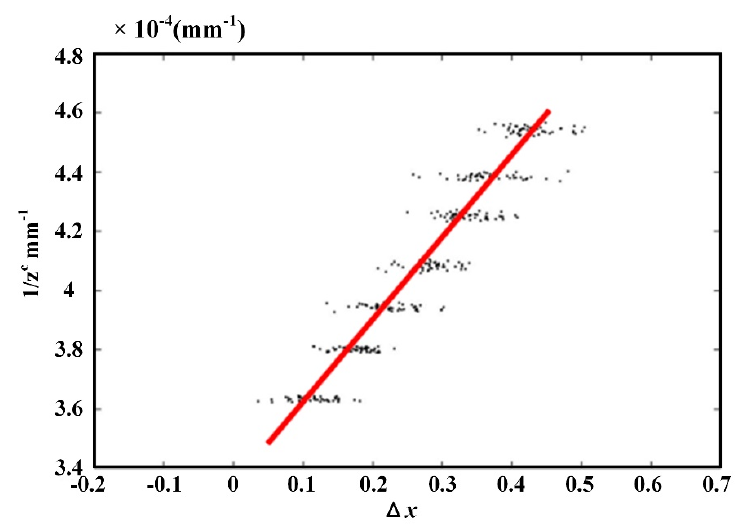
Figure 7. Calibration posture results of light field cameras.